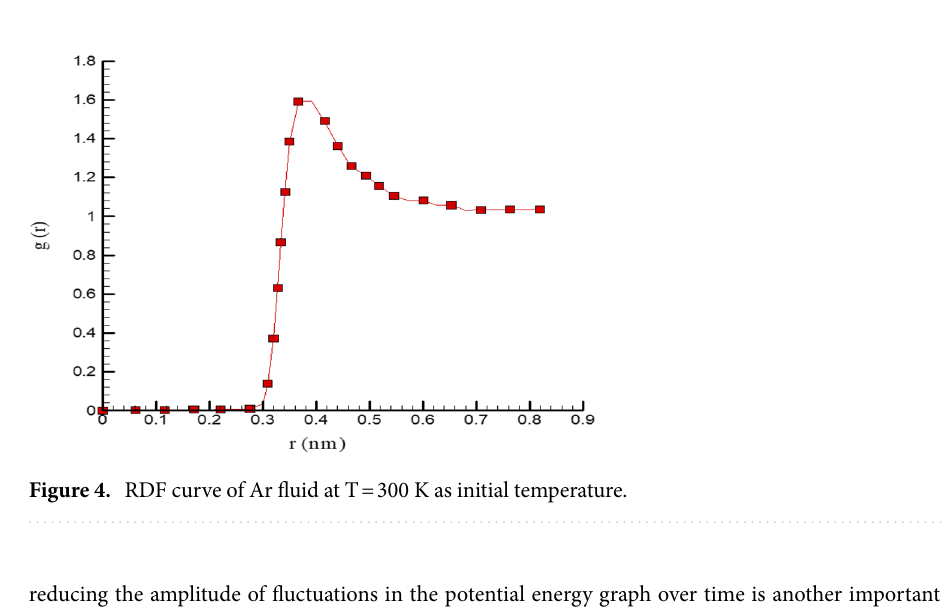
Figure 3. The Potential energy changes vs. time in the simulated atomic structure in the existence of carbon nanotubes (7 and 7) with a length of 5 nm at the initial temperature (300 K).